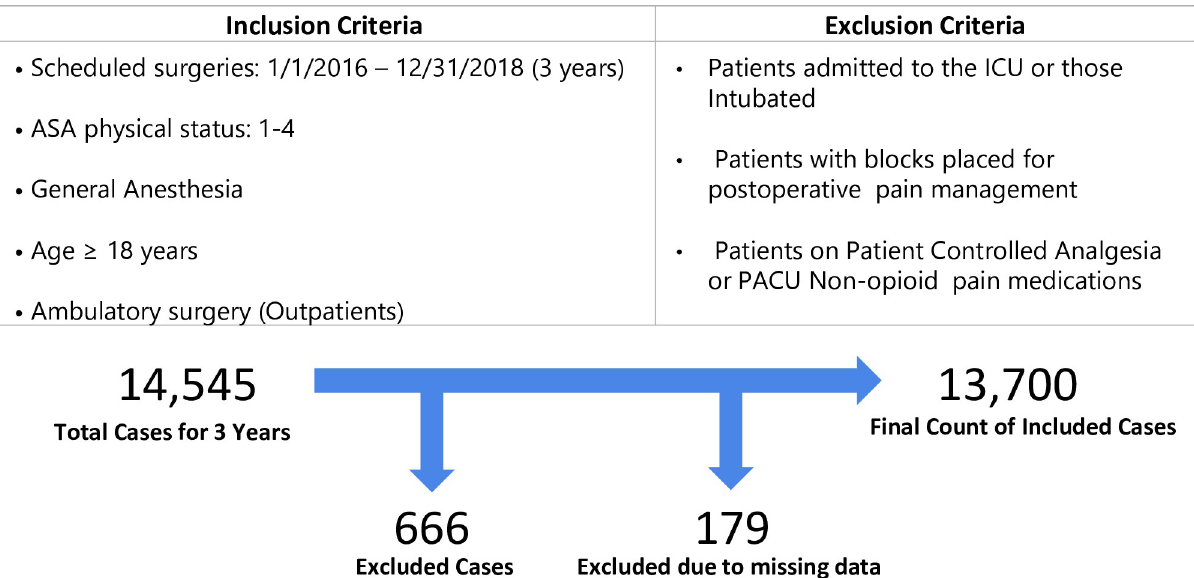
Fig 1. Inclusion and exclusion criteria used to select the cohort for the study are shown. The total count of patients, the number of exclusions and the final count of patients are shown.